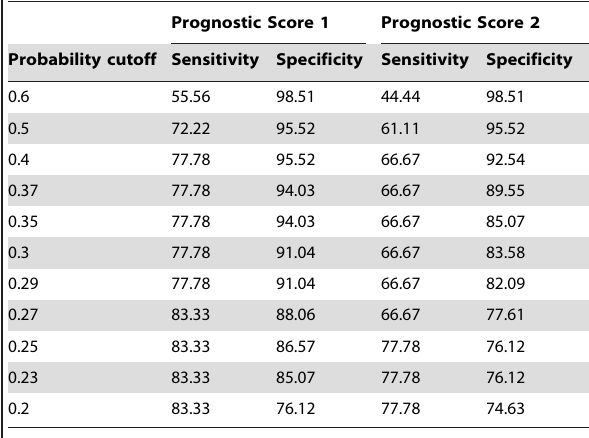
Prognostic Score 1. Linear score model based on the multiple logistic regression that included the six significant covariates described in Table 2. Prognostic Score 2. Linear score model based on the multiple logistic regression that included the four significant covariates described in Table 2.